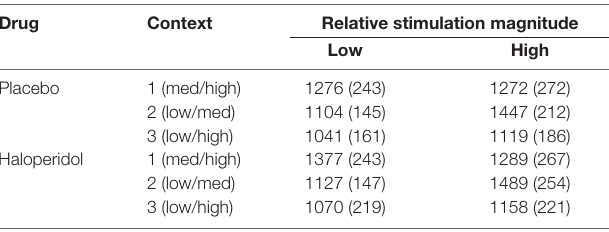
TABLE 4 | RTs of hits in the adaptive task ( n = 20).